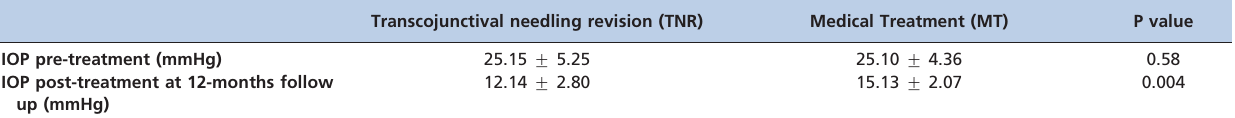
Table 2 - Average intraocular pressure before and after randomization (at the 12-month follow-up) in the TNR and MT